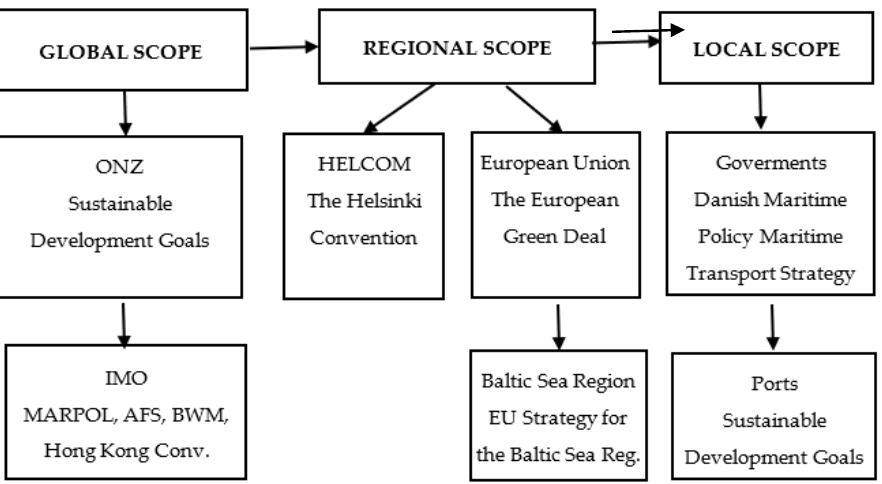
Figure 2. Selected legal solutions for the protection of marine environment. Source: own elaboration.